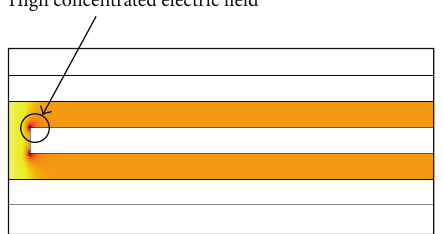
Figure 10: Electric field distribution of single finger straight electro- static conventional comb drive